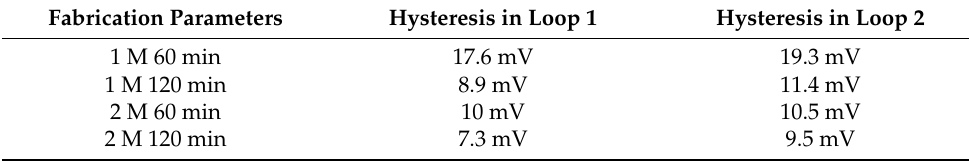
Table 2. Hysteresis width of the tested